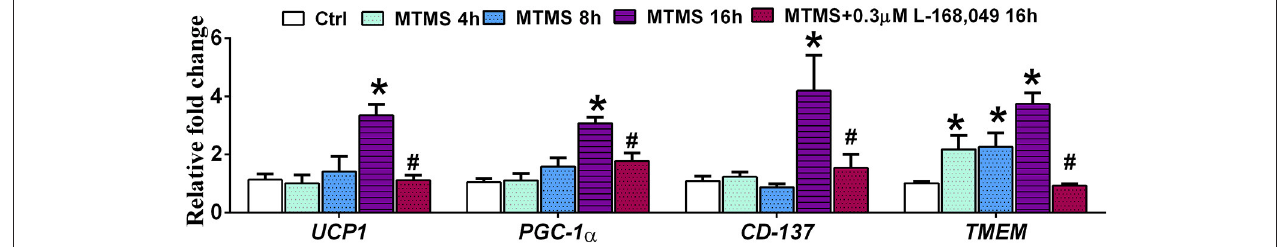
FIGURE 9 | Effect of serum (glucagon containing) of menthol treated mice on mature 3T3L1 adipocytes. Effect of serum of menthol treated mouse on mRNA expression of energy expenditure related genes in mature differentiated 3T3L1 adipocytes in presence and absence of L-168,049 (non-competitive antagonist of the human glucagon receptor), n = 4. All the values are expressed as mean ± S.E.M; Analysis was carried out by one way ANOVA followed by Tukey’s multiple comparison; * p < 0.05 vs. Ctrl; # p < 0.05 vs. MTMS at 16h. MTMS, menthol treated mouse serum; h, hour.